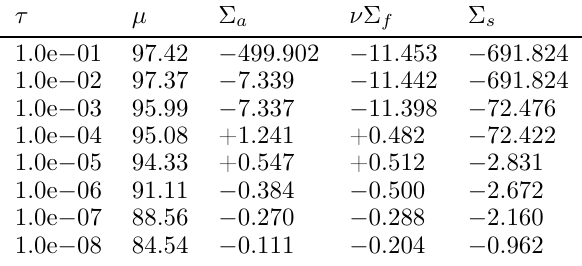
Table 9. Error on macroscopic cross sections after lossy compression by truncated HT on the MOX dataset with separate matrices M per nuclide and